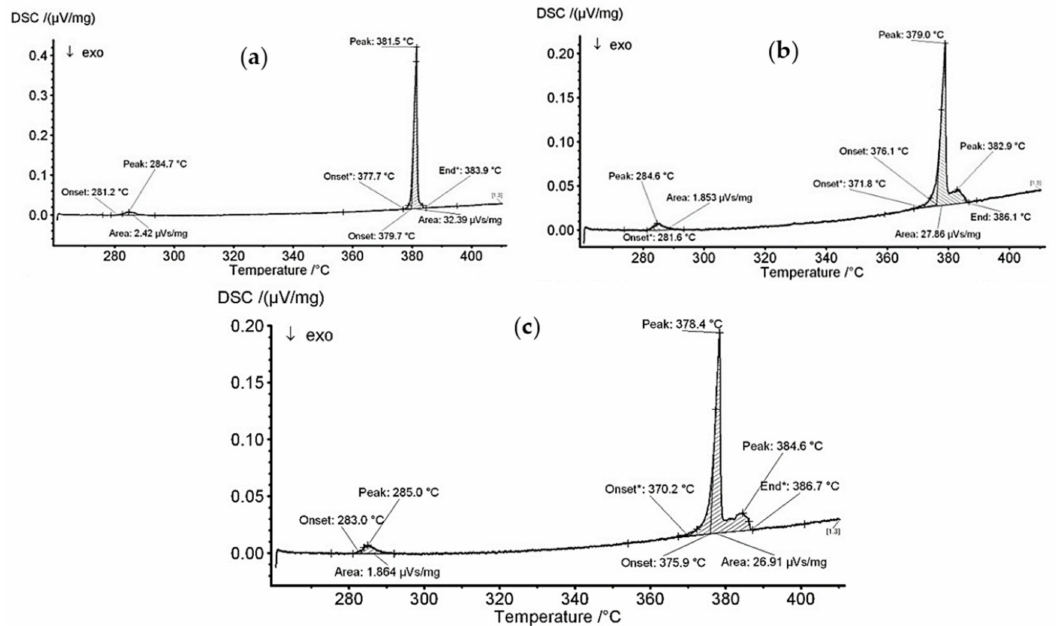
Figure 5. DSC curves of soldering alloys: ( a ) Zn5Al1Cu; ( b ) Zn5Al2Cu; ( c ) Zn5Al3Cu, at the heating rate of 1 K · min − 1 . * manually extrapolated point.